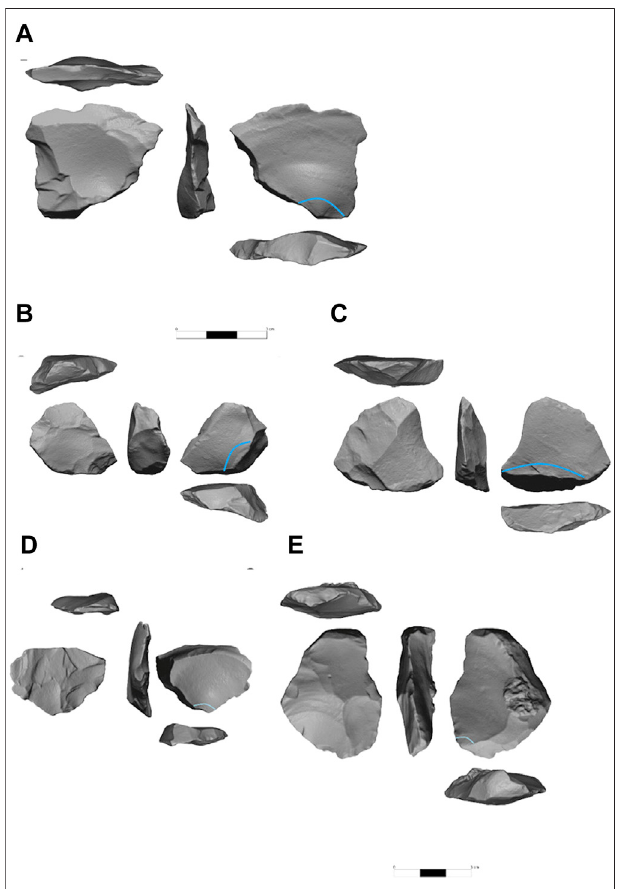
FIGURE 8 | Éclats débordants CTEs from Jaljulia. The bulb of percussion is highlighted by a blue line. (A – D) Éclats débordants ; (E) Outrepassé . Note that for this item, not only has the lateral ridge of the core been removed but the distal one as